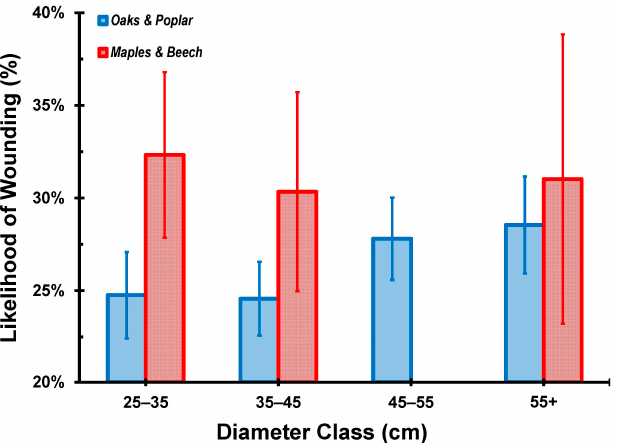
Figure 3. The likelihood of wounding by increasing 10 cm diameter class, as separated by thick-barked (oaks and yellow-poplar; blue) and thin-barked (maples and American beech; red) species. Error bars are ± 1 standard error. There are no significant differences ( p < 0.05, Tukey’s HSD) among mean likelihoods for either species group. Note that no 45–55 cm diameter, thin-barked species were sampled.